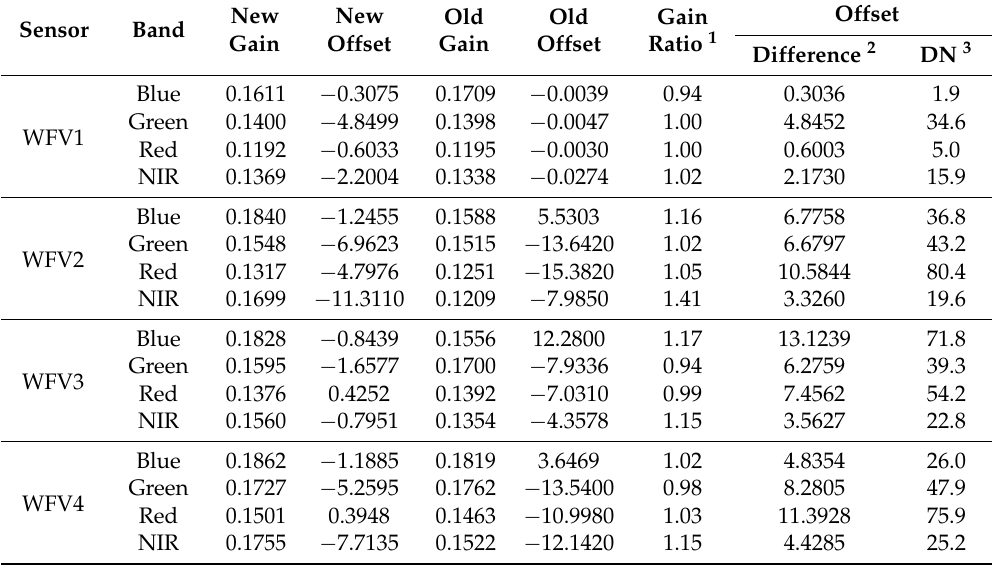
Table 3. Cross-calibrated gains and offsets (new) for four WFV sensors of Gaofen-1 satellites, also listed are the officially provided calibration coefficients (old). Differences between the two sets of calibration coefficients were